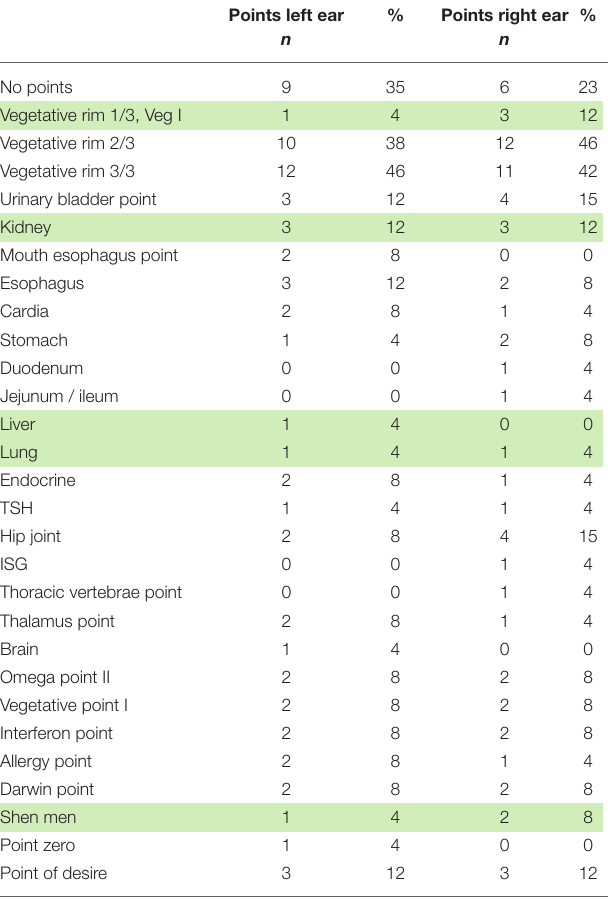
TABLE 2 | EAP and NADA points in green on the right and on the left ear lobe of newborns from drug-dependent mothers.